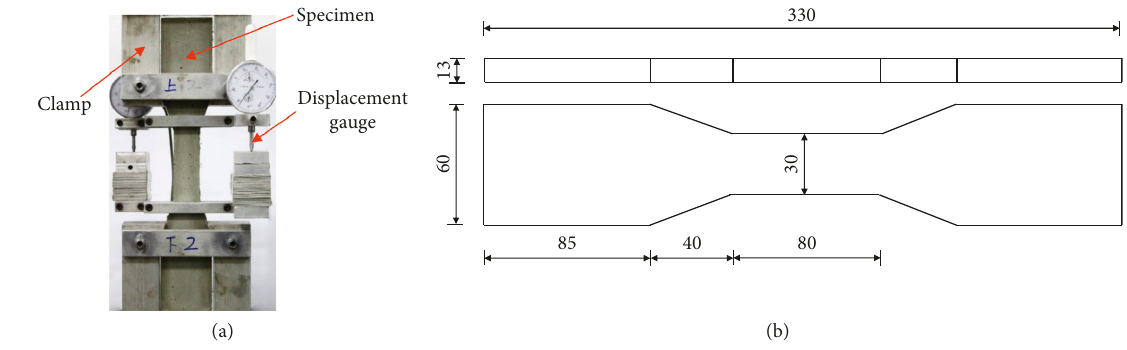
Figure 1: Uniaxial tensile test: (a) test setup; (b) dimensions of the specimen (unit: